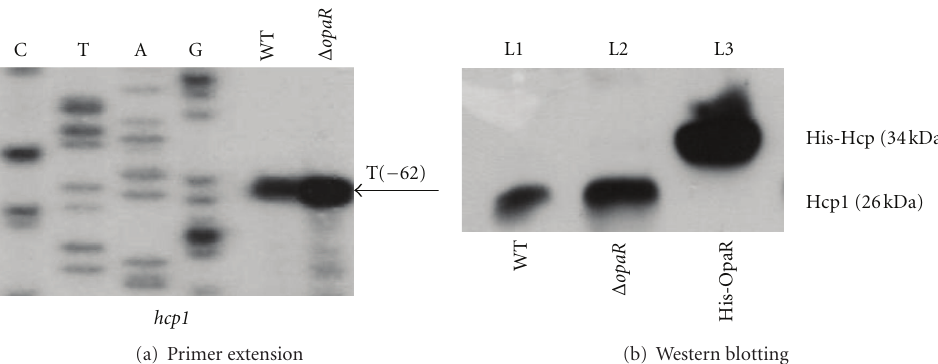
Figure 2: OpaR-dependent expression of Hcp1. (a) Primer extension. An oligonucleotide primer was designed to be complementary to the RNA transcript of opaR . The primer extension products were analyzed with 8M urea—6% acrylamide sequencing gel. Lanes C, T, A, and G represent the Sanger sequencing reactions. The transcription start site of hcp1 was underlined in the DNA sequences. (b) Immunoblot analysis.The Hcp1 production was detected in WT or Δ opaR , while His-Hcp1 was used as positive control.